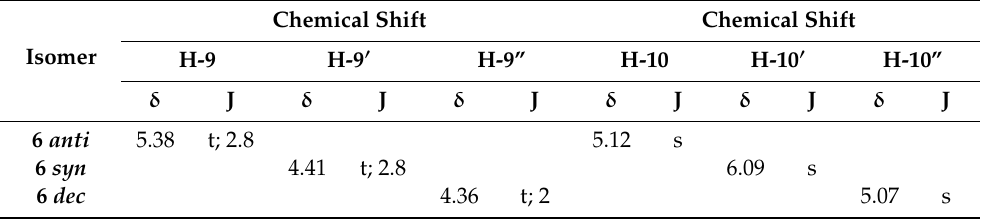
Table 2. The distinguishing between the isomers 6 anti , 6 syn, and 6 dec using chemical shifts. Chemical Shift Chemical Shift Isomer H-9 H-9 (cid:48)